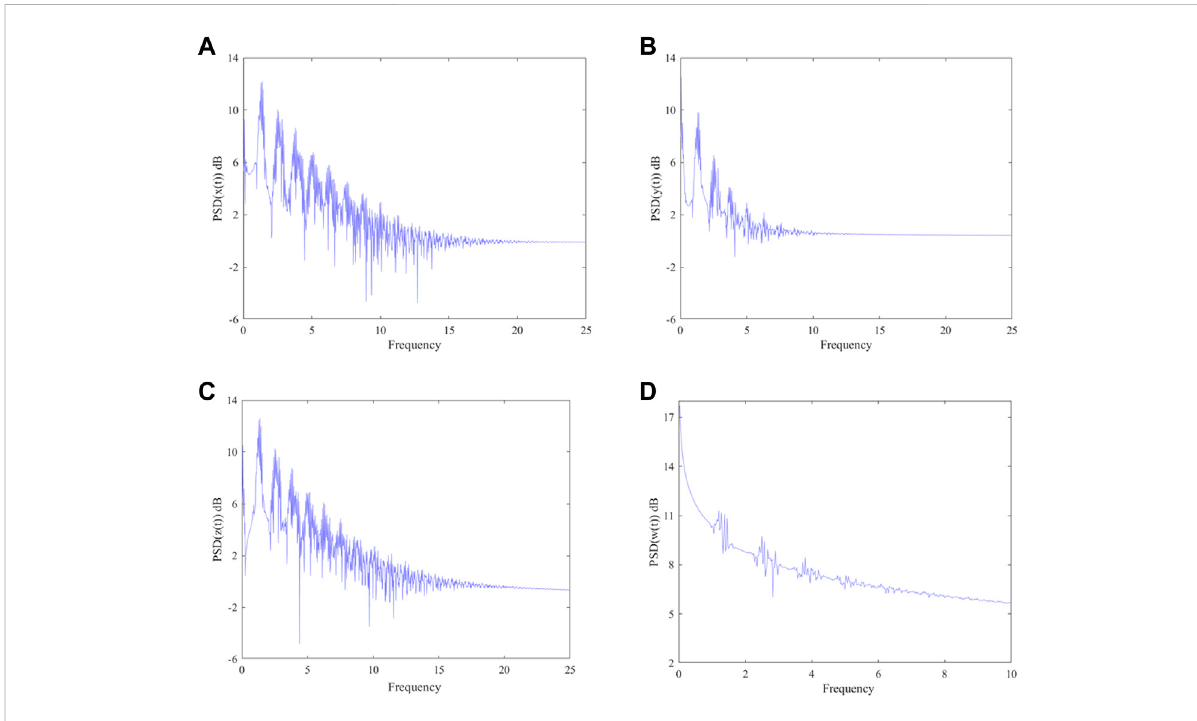
FIGURE 7 Frequency power spectra of the MSMFrLVS in: (A) x, (B) y, (C) z, (D) w